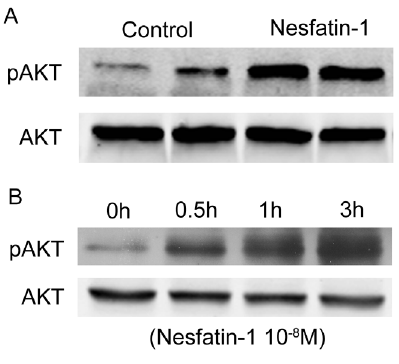
Figure 3. Effects of nesfatin-1 on AKT phosphorylation in pancreas (A) and min6 islet cells (B). (A) Mice were fed high fat diet for 8 weeks, then received subcutaneous infusion of saline (control) or nesfatin-1 for 2 weeks. Levels of AKT phosphorylation were examined in pancreas by Western blotting using specific antibody. Shown are representative results from 6 individual experiments. B. Cultured min6 islet cells were treated with nesfatin-1 at a dose of 10 2 8 M for the time indicated. Shown is the representative western blot from 3 separate experiments.